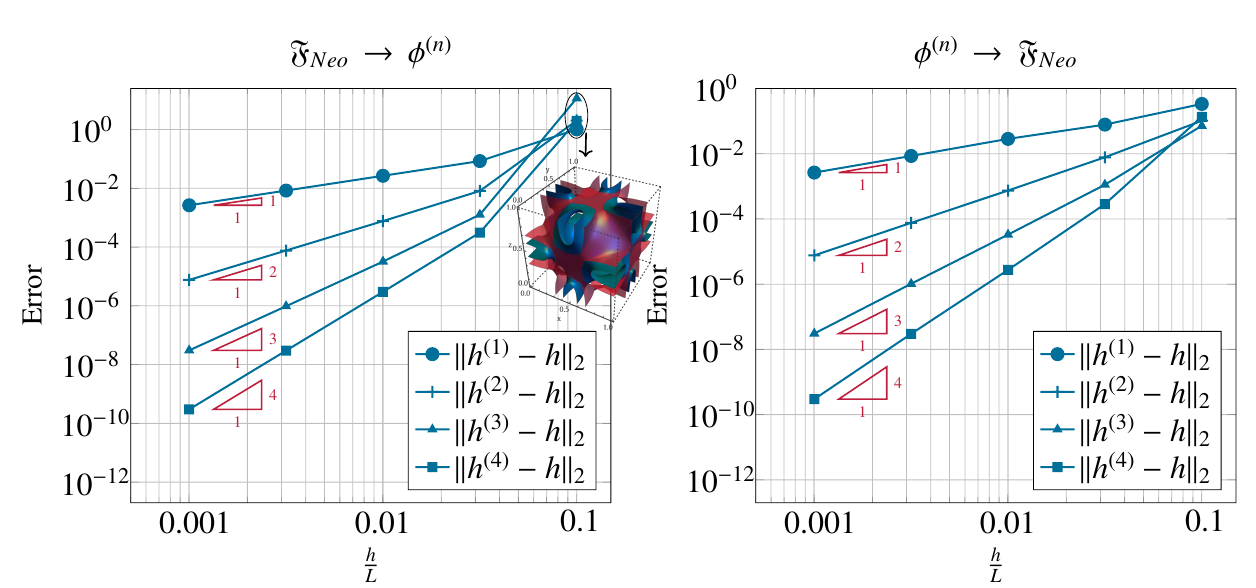
Figure 7. Neovius convergence study. In both panels, the error in the measured offset h m is plotted against different predefined normalized offsets. In the left figure, the offsets were measured starting from points on F Neo ( (cid:126) x ) = 0 to points on each surface φ ( n ) ( (cid:126) x , h ) = 0, respectively. In the right figure, the measurement direction is reversed. The triangles represent the corresponding slope for each order n . The nonasymptotic behavior shown at offsets of larger values (e.g., h / L = 0.1) is attributed to the high curvature of the original